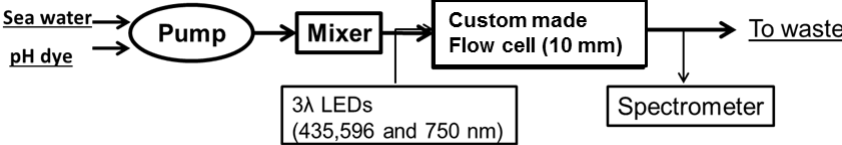
Figure 2. Schematic of the Lab-on-Chip pH analyser. The microfluidic flow cell comprised of an absorption cell and static mixer produced in poly(methyl methacrylate) (PMMA) [45]. Two syringe pumps (Harvard Apparatus Nanomite, Kent, UK) and four micro-inert valves (LFNA1250125H, Lee Products Ltd., Gerrards Cross, UK) controlled the fluidics and were directly mounted on the chip. The 10 mm absorption cell was connected to the light source and detector by two optical fibers (600 μm diameter, Thorlabs Inc., Newton, NJ, USA), and had a volume of 5 μL. A tri-colored LED was used as lightsource, with wavelengths: 435 nm and 596 nm corresponding to the absorption maximum of the Thymol Blue indicator forms HI − and I 2 − , and 750 nm to monitor turbidity of the sample. A linear array photodiode spectrophotometer (HR4000, Ocean Optics, Oxford, UK) was used as detector.